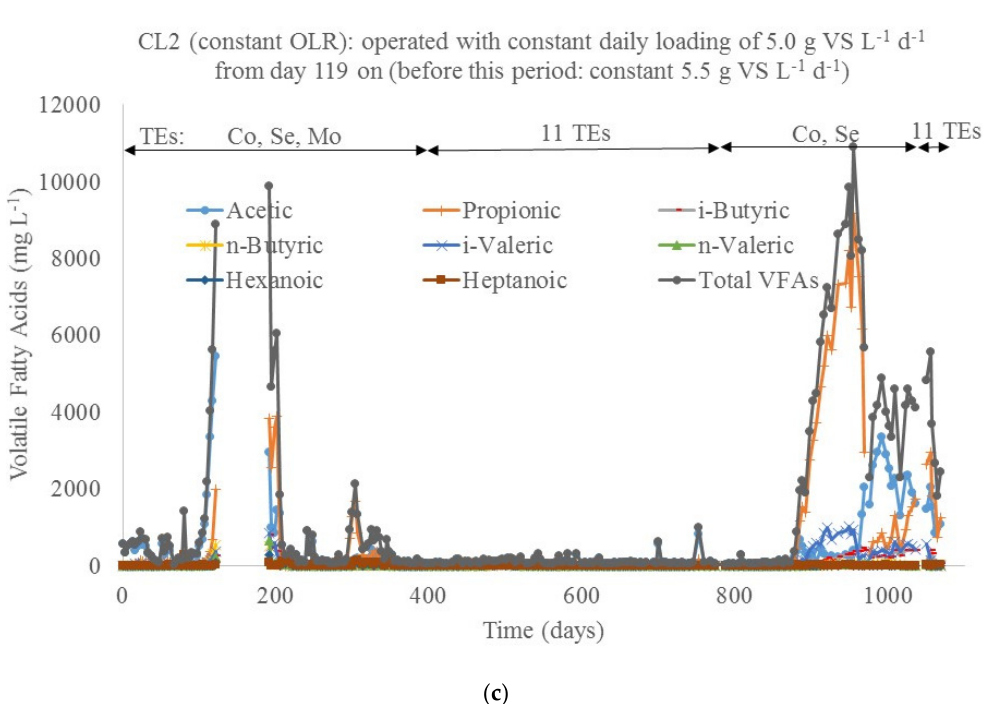
Figure 2. Volatile fatty acids (VFA) profiles: ( a ) Digester VL with varying organic loading rate; ( b ) Control digester CL1; ( c ) Control digester CL2. (Note: 1. These digesters had the same constant OLR until day 105 and from day 966 on, but not always the same TE supplementation scheme; 2. The digester CL2 suffered from a severe operation problem on day 103: water in biogas counter was siphoned back to the digester causing disturbance and VFA increase for a period of 200 days. The VFA peak after that event was not displayed fully in Figure 2c due to its scale; 3. The y-axis scale of control digester CL2 is different from others due to its high VFA peak around day 1000.).